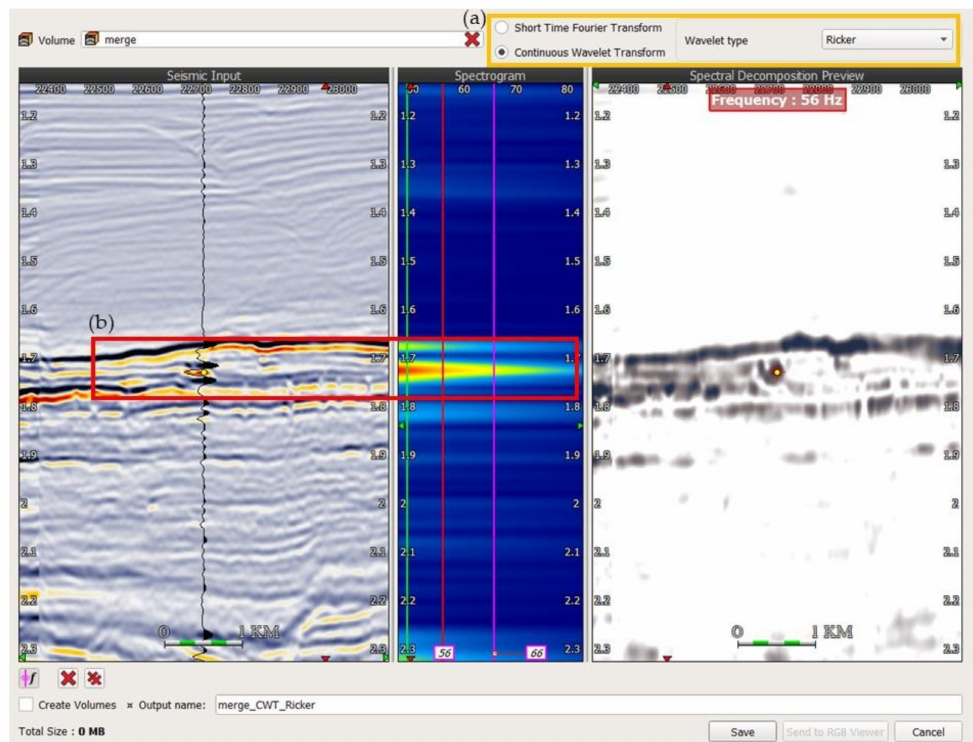
Figure 7. The frequency picked window which allows ( a ) Several methods of spectral decomposition. A simple method of short-time Fourier transform (STFT) and two methods of continuous wavelet transform (CWT), using Morlet or Ricker wavelets ( b ) Associated frequencies of the targeted karst geobody which can be directly picked in the spectrogram viewer.